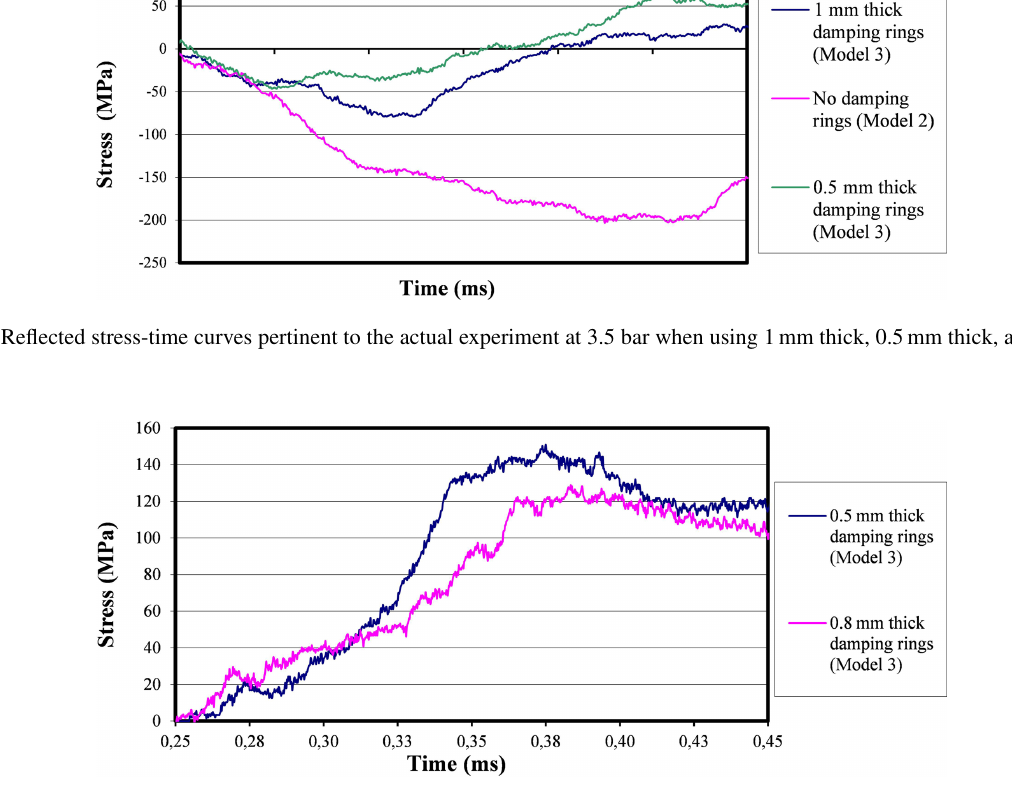
Figure 33. Stress-time curves found in the transmission bars pertinent to the actual experiment at 3.5bar when using 0.8mm thick and 0.5mm thick damping